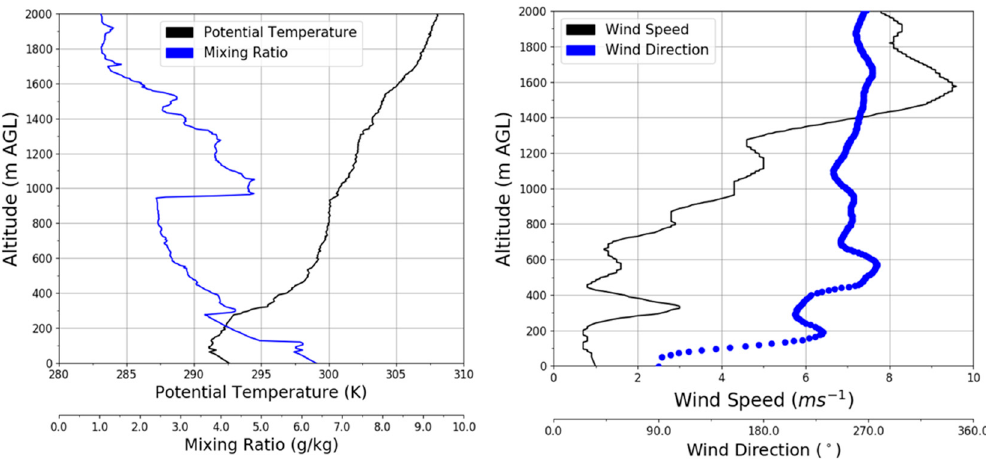
Figure 5. Upper-air radiosonde sounding taken at 0900 PST from the experimental site on 22 June 2012. Left panel shows potential temperature and water vapor mixing ratio and right panel shows wind speed and direction.